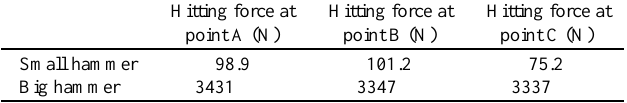
Table 2 Average force on the beam and the bond arm